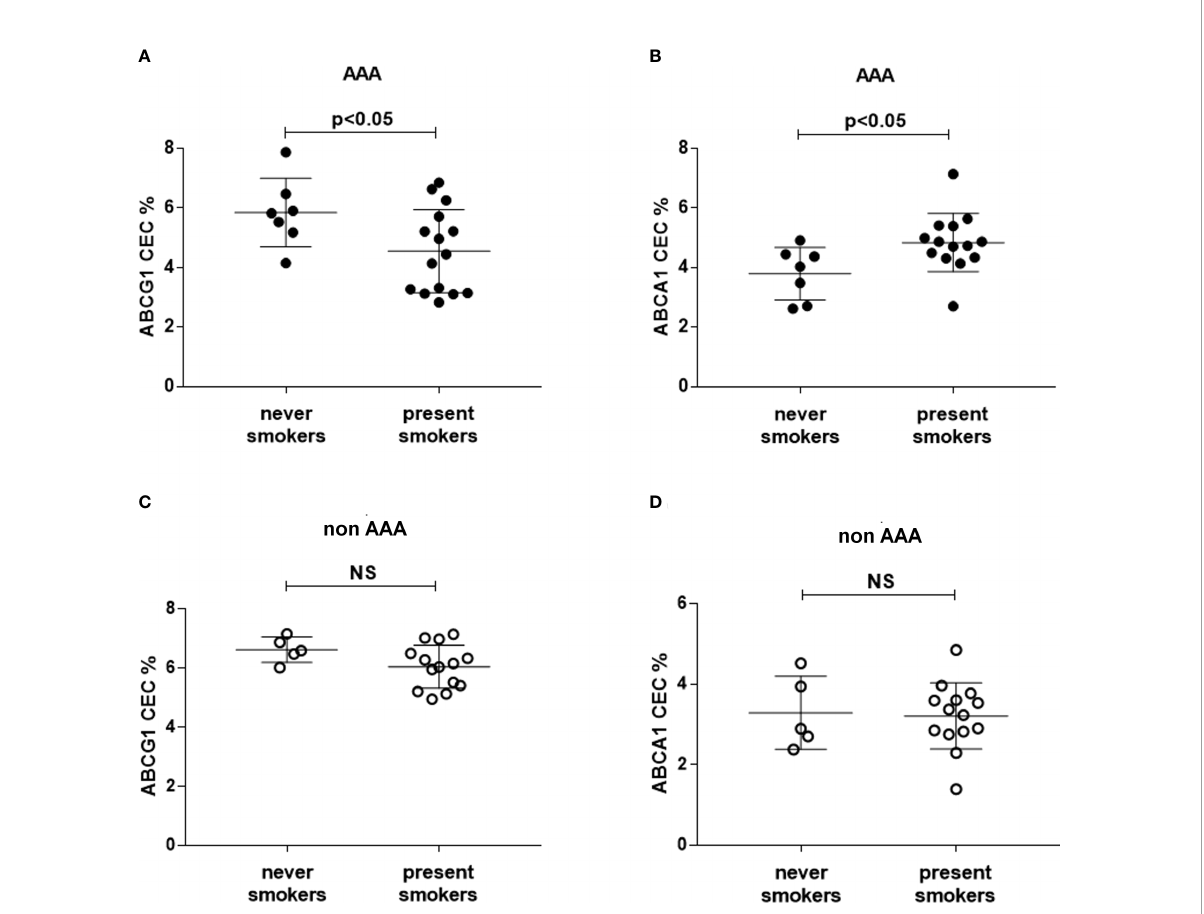
FIGURE 4 HDL CEC in smoker and non-smoker patients. ABCG1-CEC (A, C) and ABCA1-CEC (B, D) values were strati fi ed into never (N=5 and N=7 for controls and AAA, respectively) and present smokers (N=14 and N=15 for controls and AAA, respectively). Mean and SD for each group are reported. The unpaired Mann – Whitney test for statistical analysis of parameters with skewed distribution was applied. NS, not signi fi